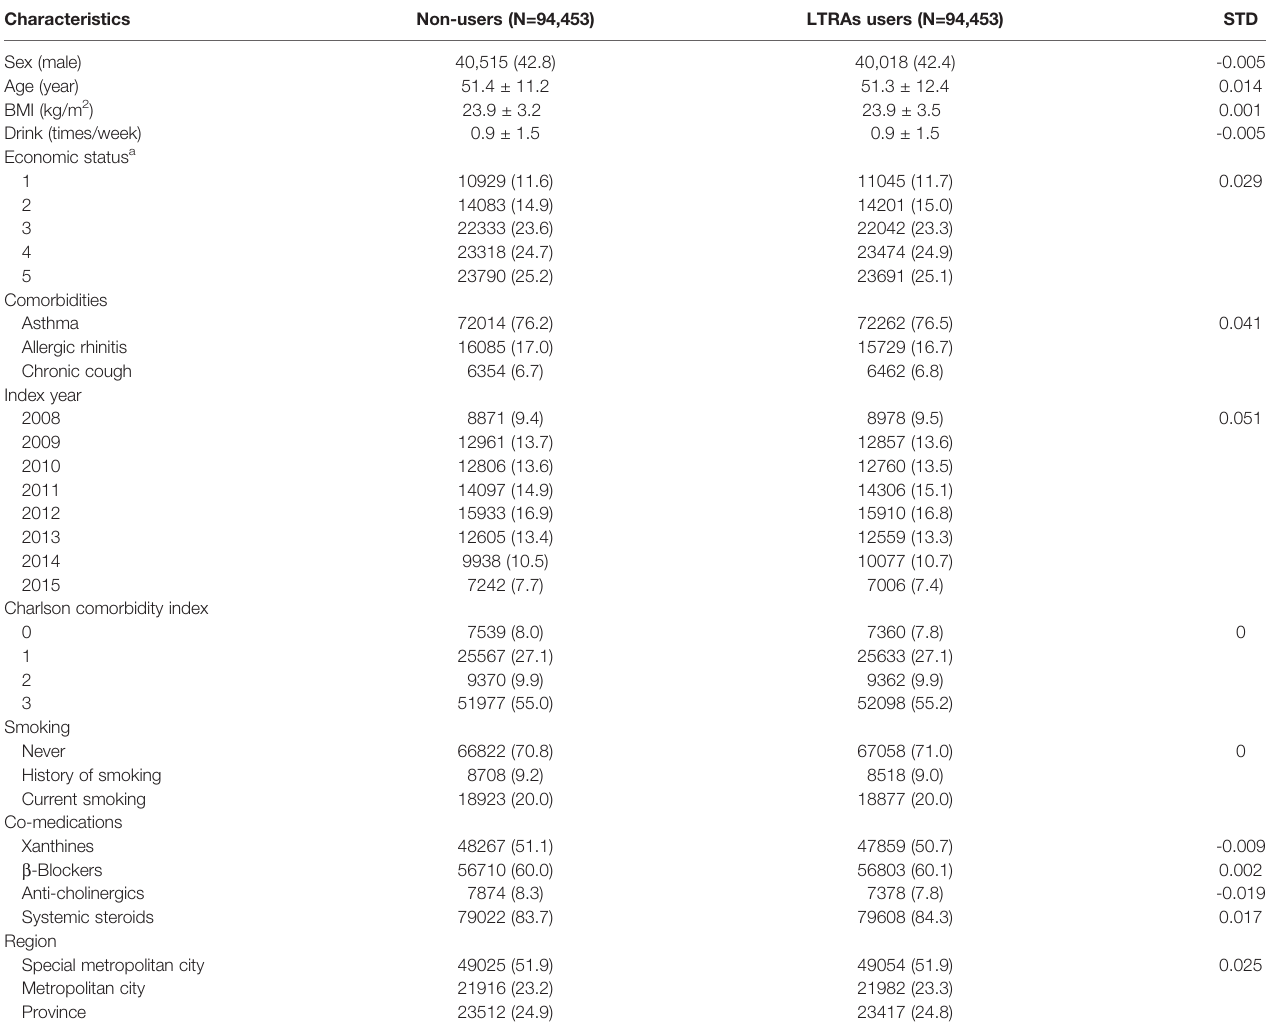
TABLE 1 | Baseline